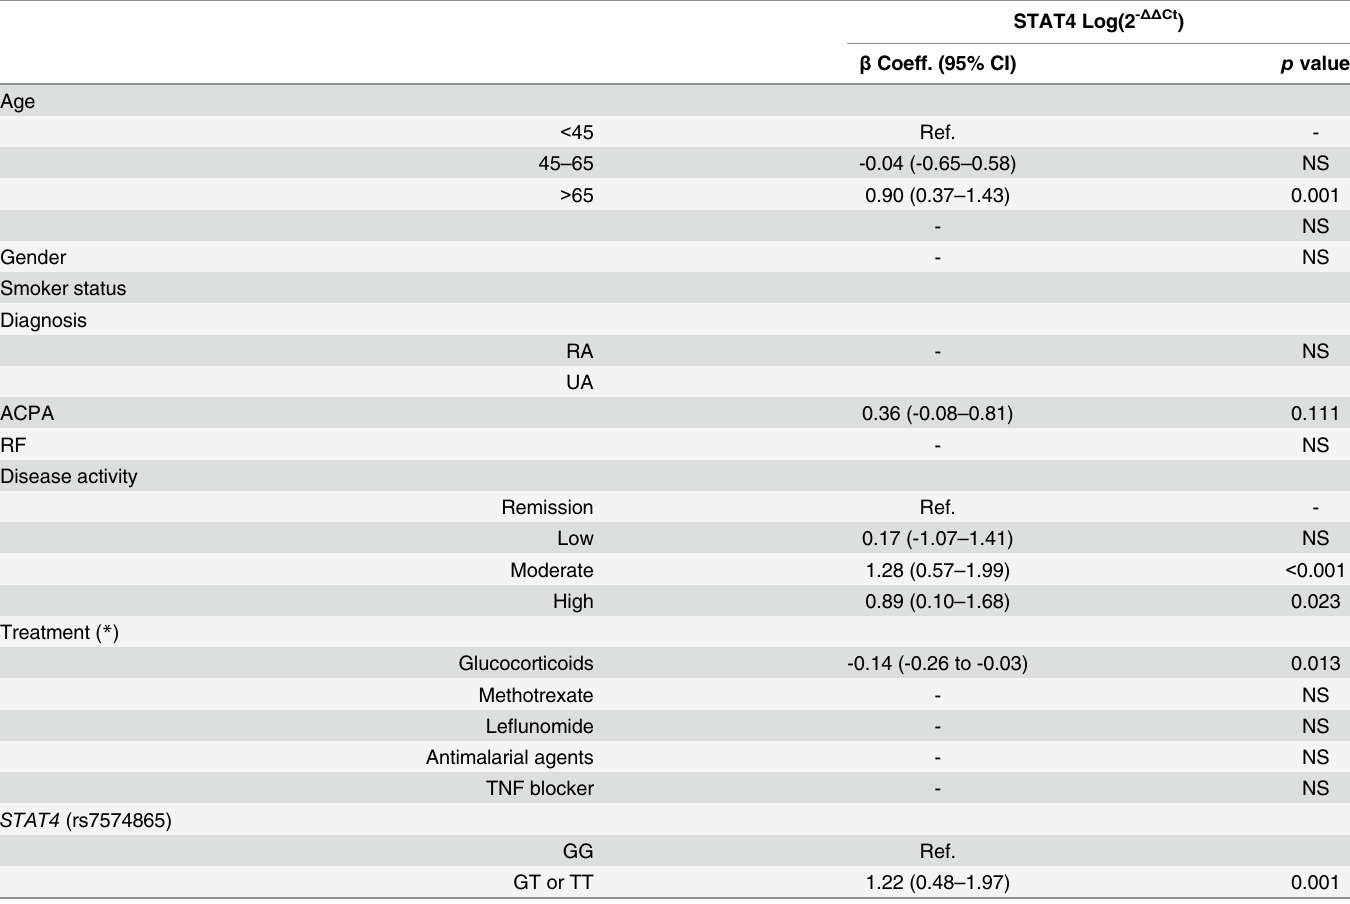
Table 2. Effect of different characteristics on STAT4 mRNA levels in patients with early